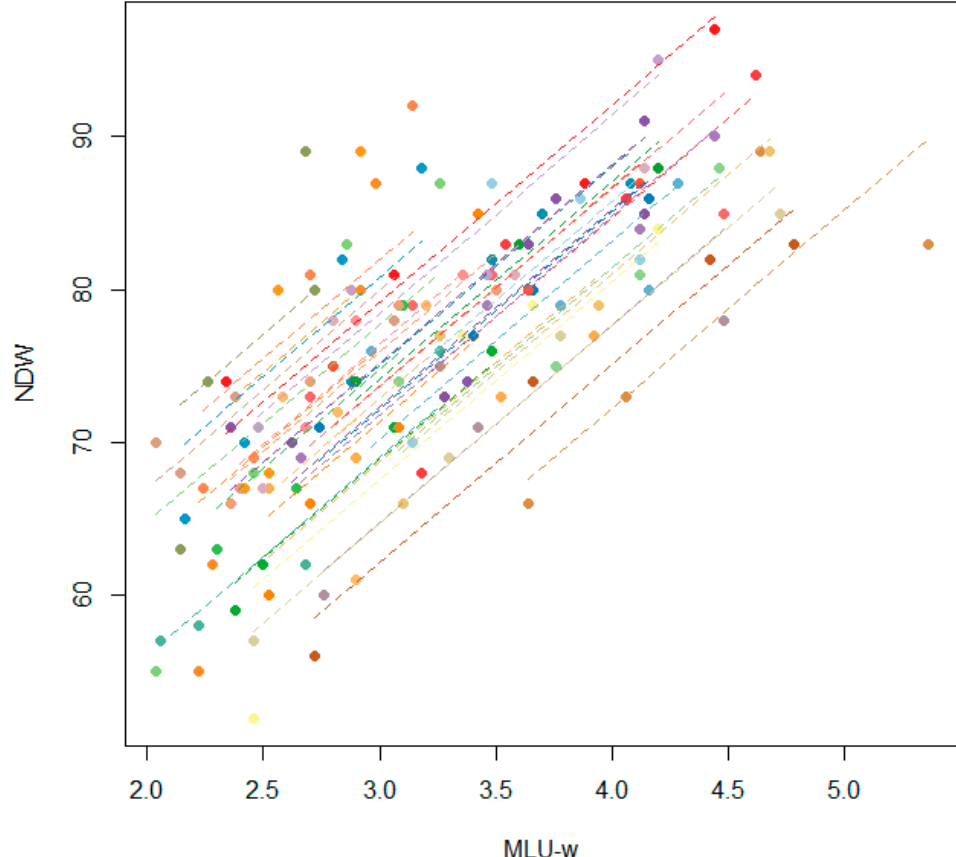
Figure 1. Scatter plot illustrating repeated measures correlations between the MLU-w and NDW with different colour used for each child; parallel lines are fitted for each